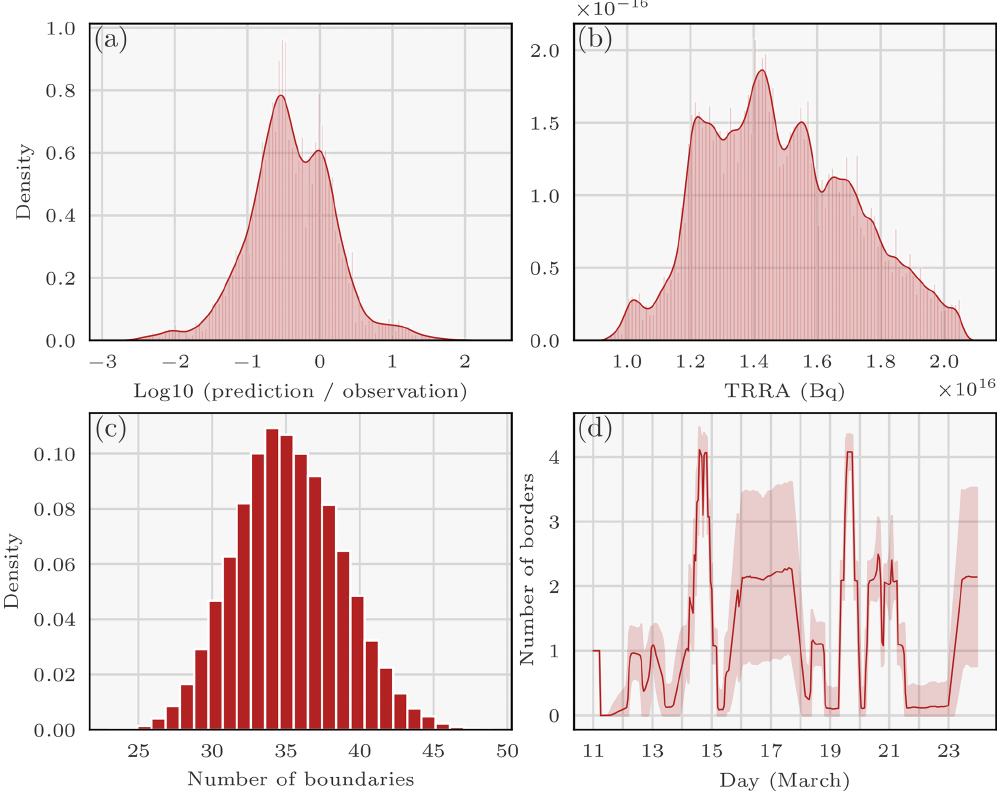
Figure 4. Densities or averages of variables describing the 137 Cs source reconstructed with the RJ-MCMC technique: (a) density of relative differences in log 10 between observations and predictions; (b) density of the total retrieved released activity (TRRA) of 137 Cs during the Fukushima Daiichi accident (in Bq) – outliers are removed; (c) histogram of the number of boundaries; and (d) mean ( ± standard deviation) of the number of boundaries as a function of time